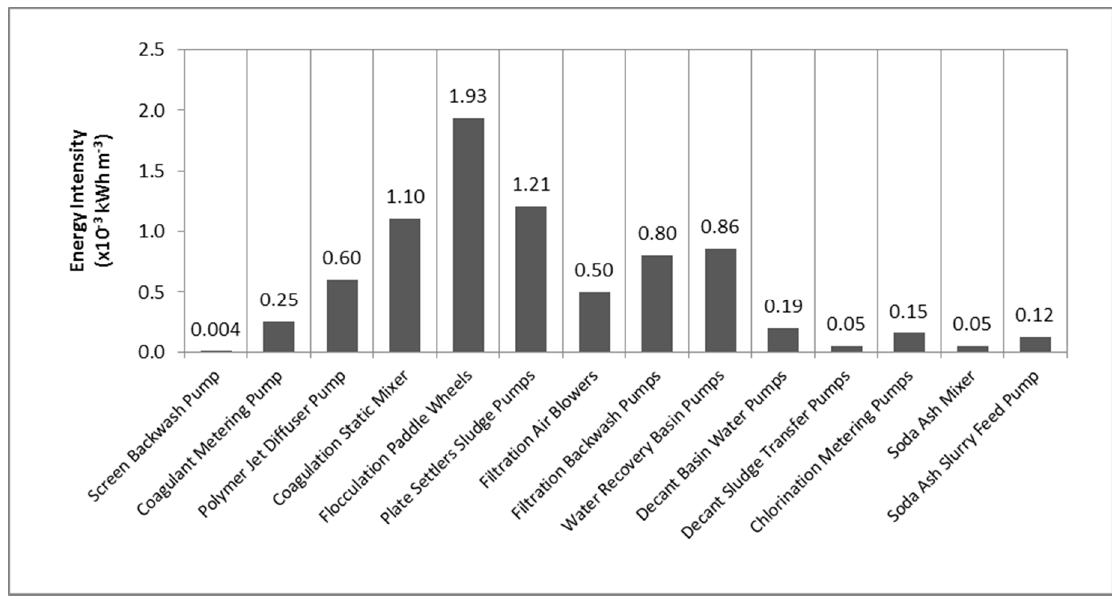
Figure 2. Results for energy consumption by percentage for water intake, water treatment units, and finished water distribution pumps for scenario S-1 (energy consumption of water treatment facility including distribution pumps) and S-2 (energy consumption of water treatment facility excluding distribution pumps).